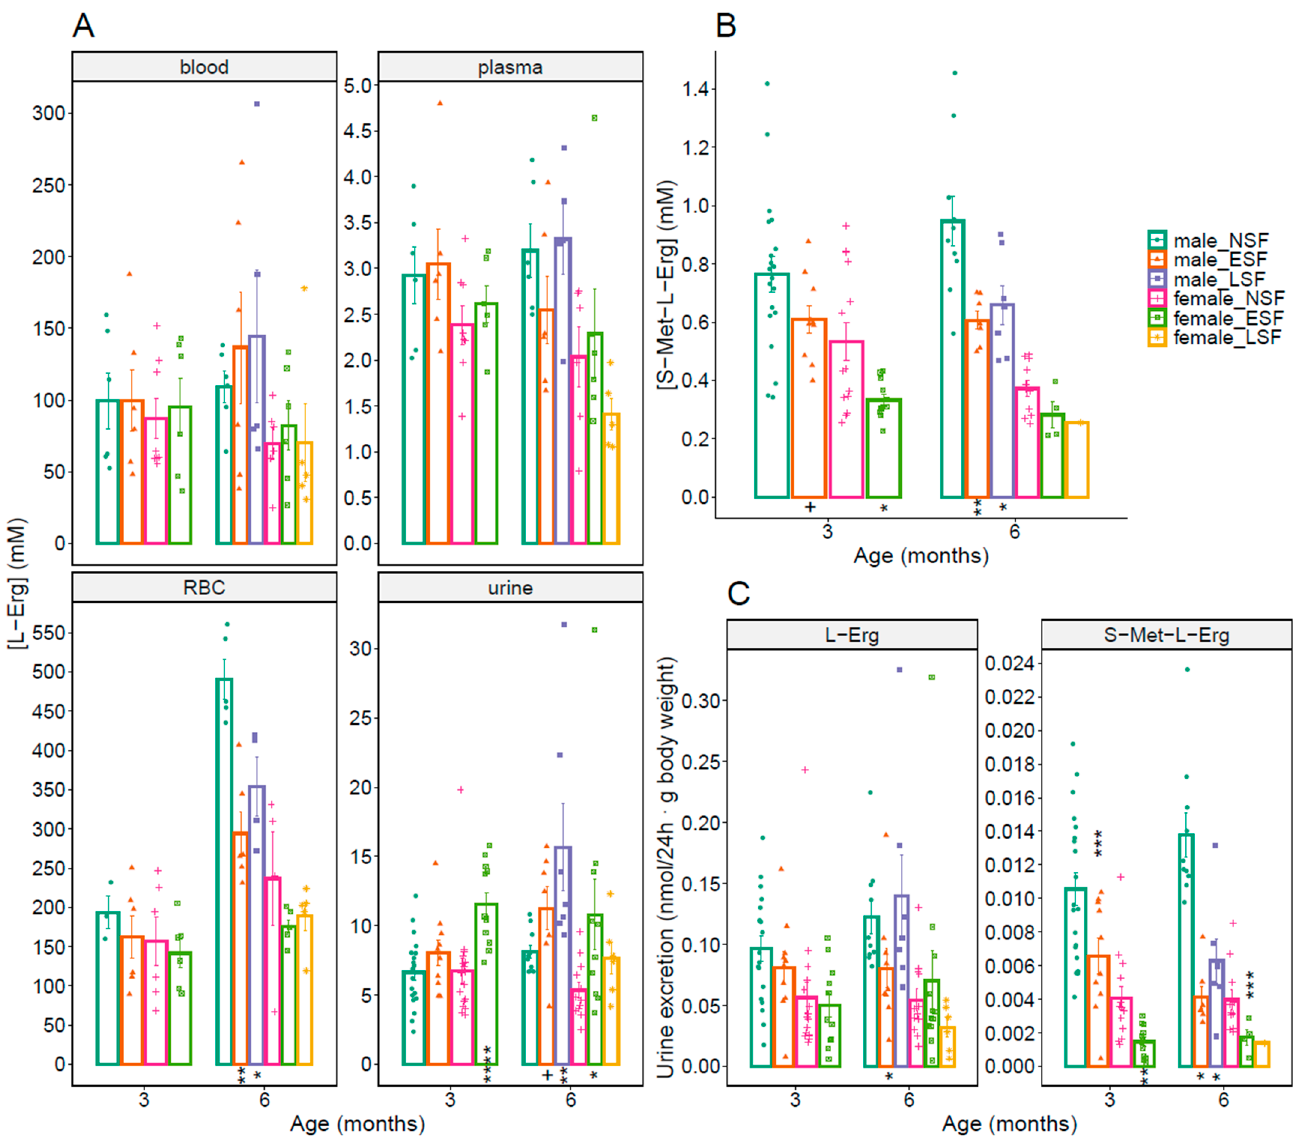
Figure 4. Cystine lithiasis-related differences of L-Erg and S-Met-L-Erg levels in WT and cystinuric ( Slc7a9 − / − ) mice at 3 and 6 months of age. ( A ) L-Erg concentration in blood, plasma, red blood cells (RBC) and 24 h urine in cystine stone non-former (NSF), early stone-former (ESF) and late stone former (LSF) cystinuric mice from both sexes. ( B ) S-Met-L-Erg concentration in 24 h urine. ( C ) L-Erg and S-Met-L-Erg excretion. Each colored symbol represents a sample (the number of mice per condition ranges from 1 to 20), and the bars indicate the mean ± SEM. Mann-Whitney probability test value is indicated below the bars as +, p ≤ 0.1; and, *, p ≤ 0.05, **, p ≤ 0.01, ***, p ≤ 0.001, ****, p ≤ 0.0001 vs . non lithiasic (NSF) mice.